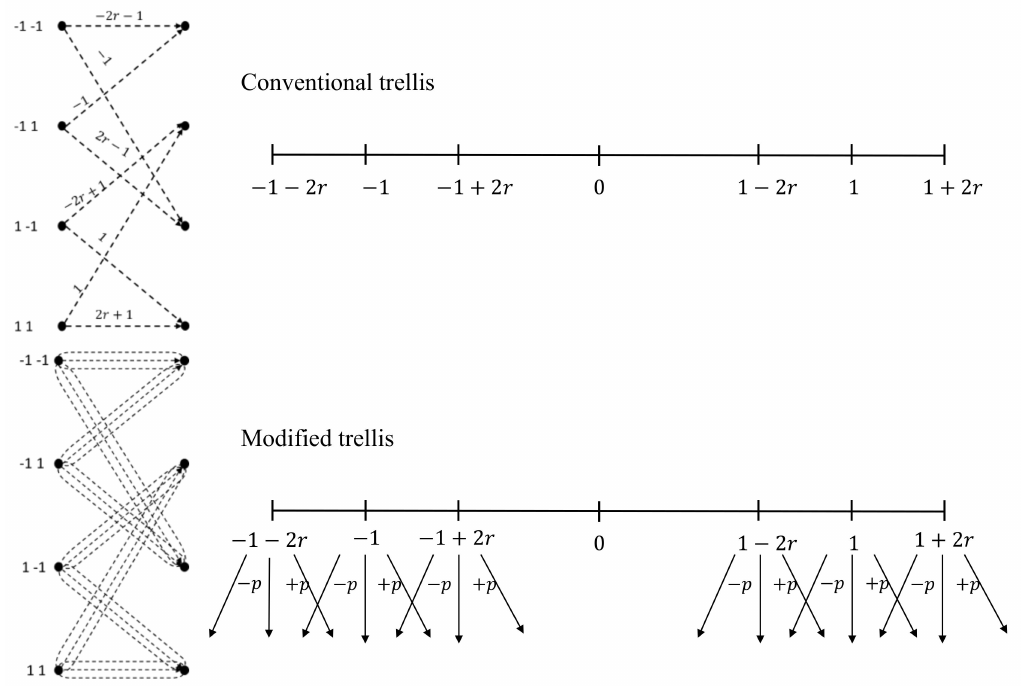
Figure 6. Alias phenomenon of the output value.